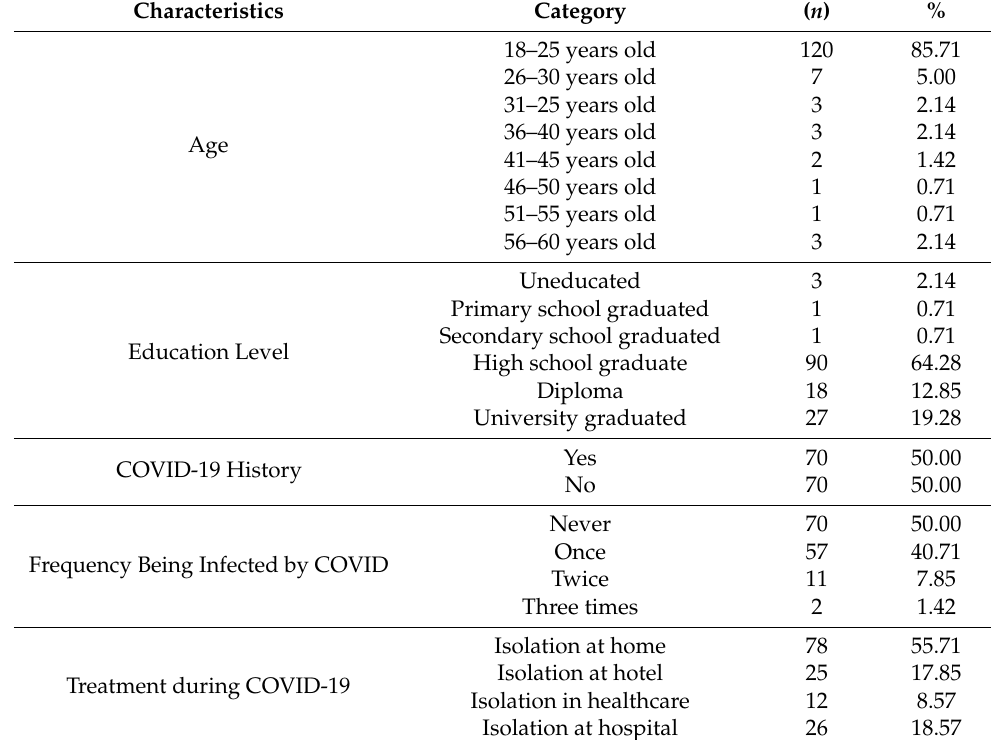
Table 1. Characteristics of the